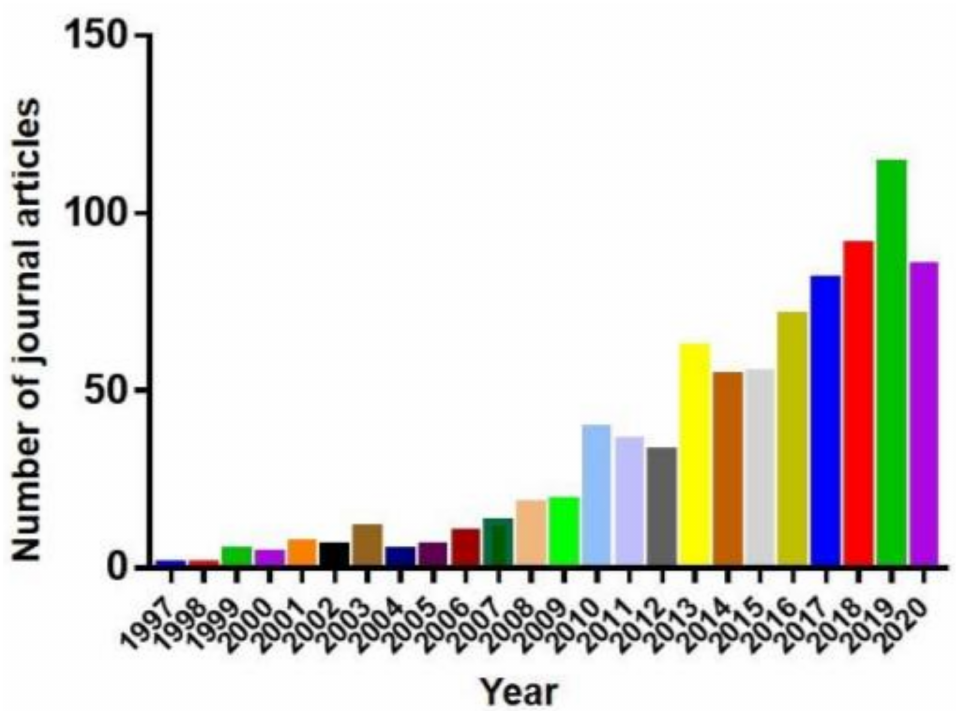
Figure 1. Absolute number of articles for zebrafish neurodegenerative diseases modelper year of publication extracted from the PubMed